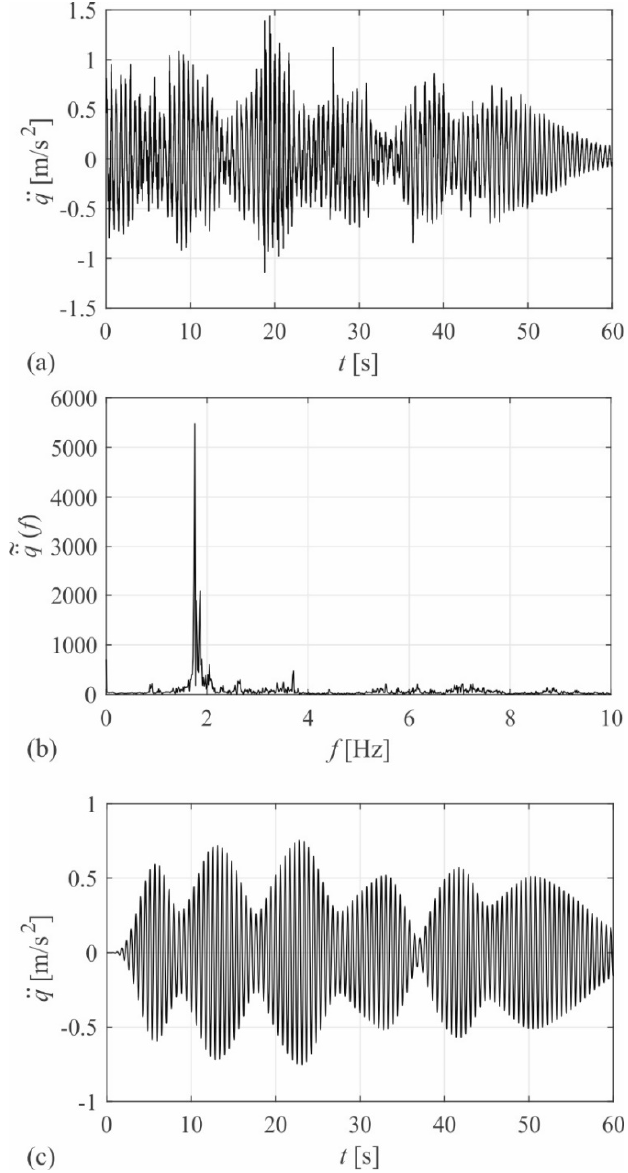
Figure 9. The measured ( a ) and filtered ( c ) vertical acceleration and Fourier spectrum ( b ) by accelerometer 2 (V2) due to a single pedestrian crossing with a step frequency of 1.75 Hz.